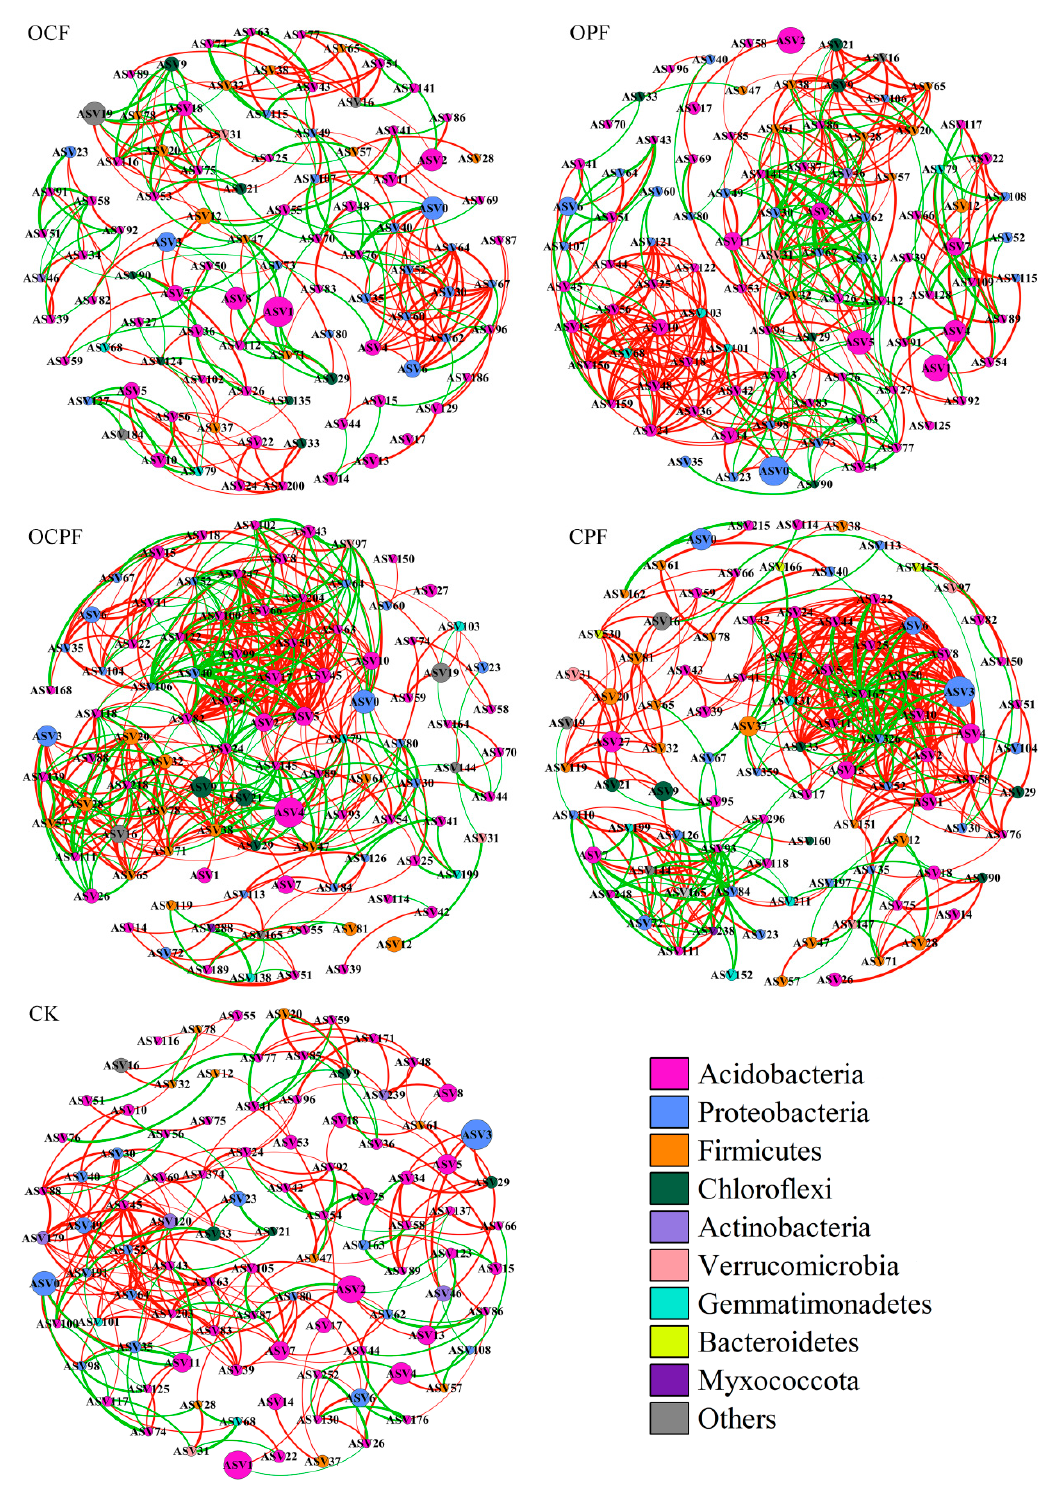
Figure 5. The co-occurrence network of bacterial communities at the ASV level in different fertilization treatments. The nodes in the network represented the 100 most abundant ASVs and each node size is based on their relative abundance. The red and green edges represented the positive and negative correlation between bacteria, respectively (Pearson, p < 0.05). The thickness of edges mainly depends on the correlation coefficient.